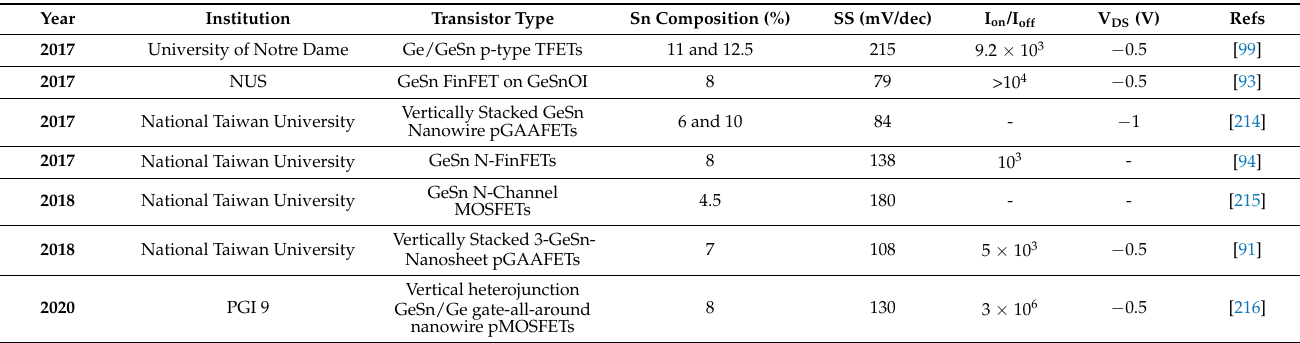
Table 8. Summary of reported transistors with GeSn layers grown by CVD technology in terms of institution, transistor type, Sn content, subthreshold swing (SS), I on /I off ratio, and V DS .